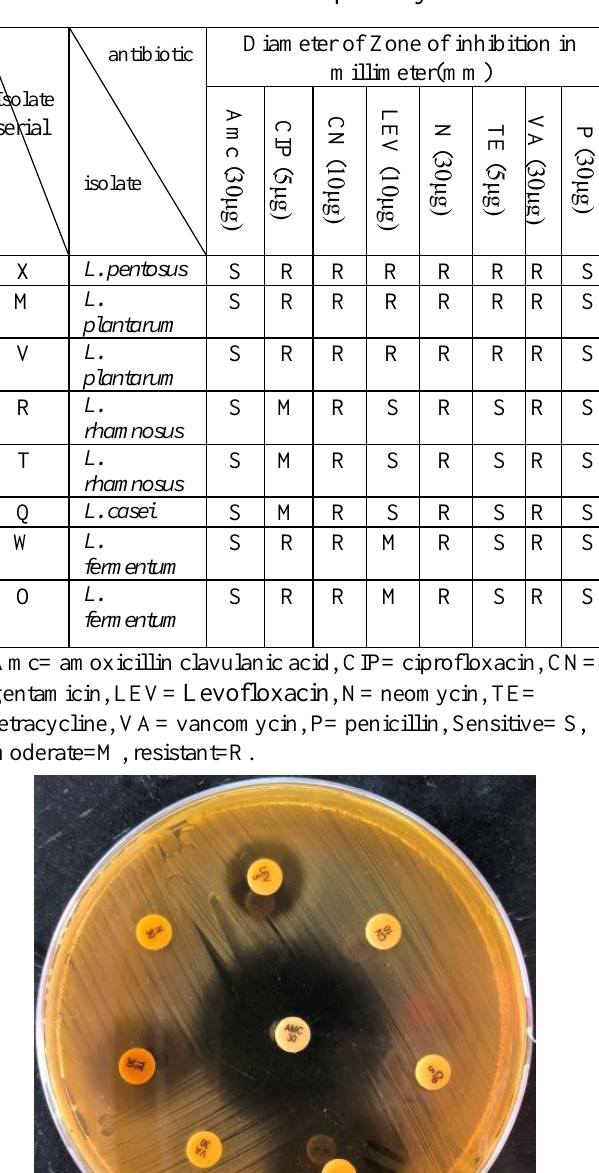
Table 5: Antibiotic susceptibility test results